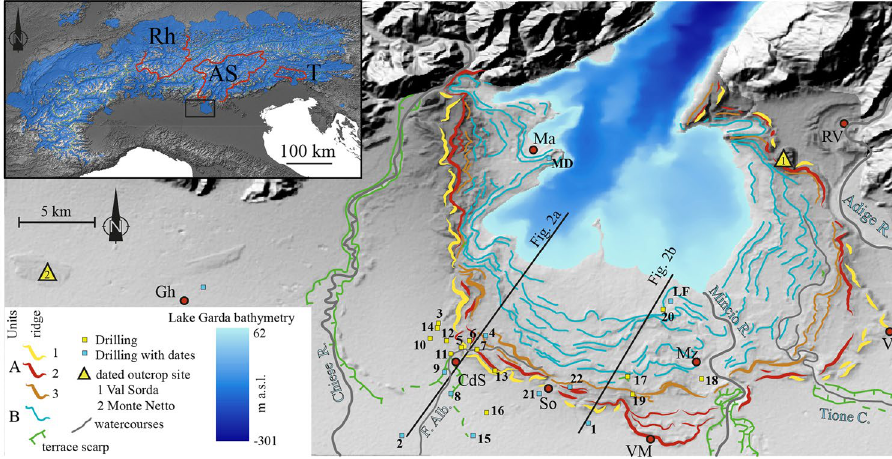
Figure 1. ( a ) Extension of the Alpine glaciers during the LGM 53 and outline of the considered catchments (AS: Adige/Sarca, RH: Rhine, T: Tagliamento), study area in the black frame. ( b ) Digital Elevation Model of the Garda end-moraine system with the major geomorphologic features, drainage ( F.Alb .: Fosso Albanella) and locations (CdS: Castiglione delle Stiviere; Gh: Ghedi; Ma: Manerba; Mz: Monzambano; So: Solferino; RV: Rivoli veronese; Vi: Villafranca; VM: Volta Mantovana) are outlined. Drillings are listes as in Table S1, LF: Lake Frassino core 37 ; MD: Manerba core 26 . Maps are generated using CNR-licensed software ArcGIS 10.4